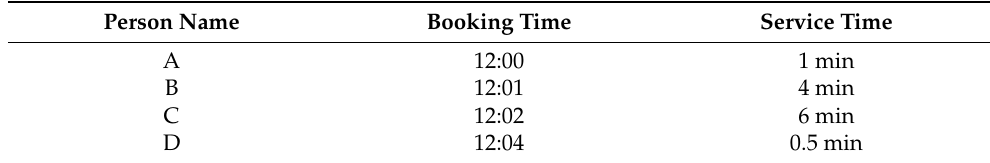
Table 2. Information about